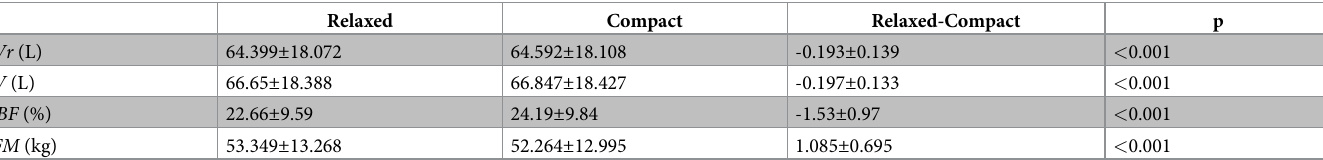
Table 2. Raw body volume ( BVr ), body volume ( BV ), percent body fat (% BF ) and fat-free mass ( FFM ) assessed during repeated ADP trials with subjects in two posi- tions (mean ± standard deviation